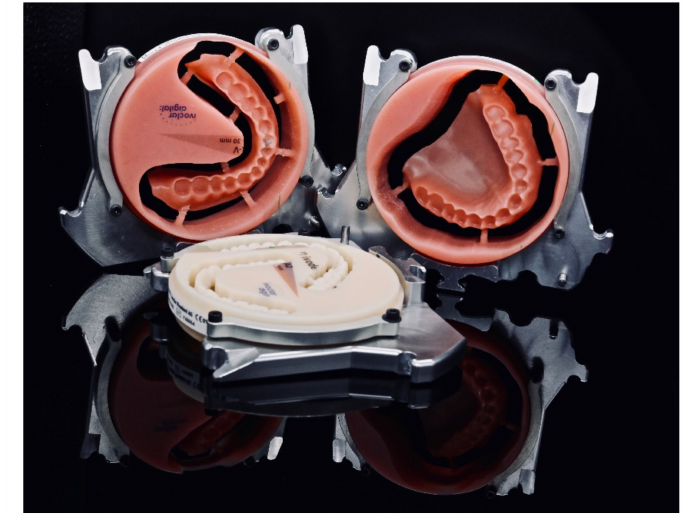
Figure 15. Denture bases and denture teeth milled from pre-fabricated